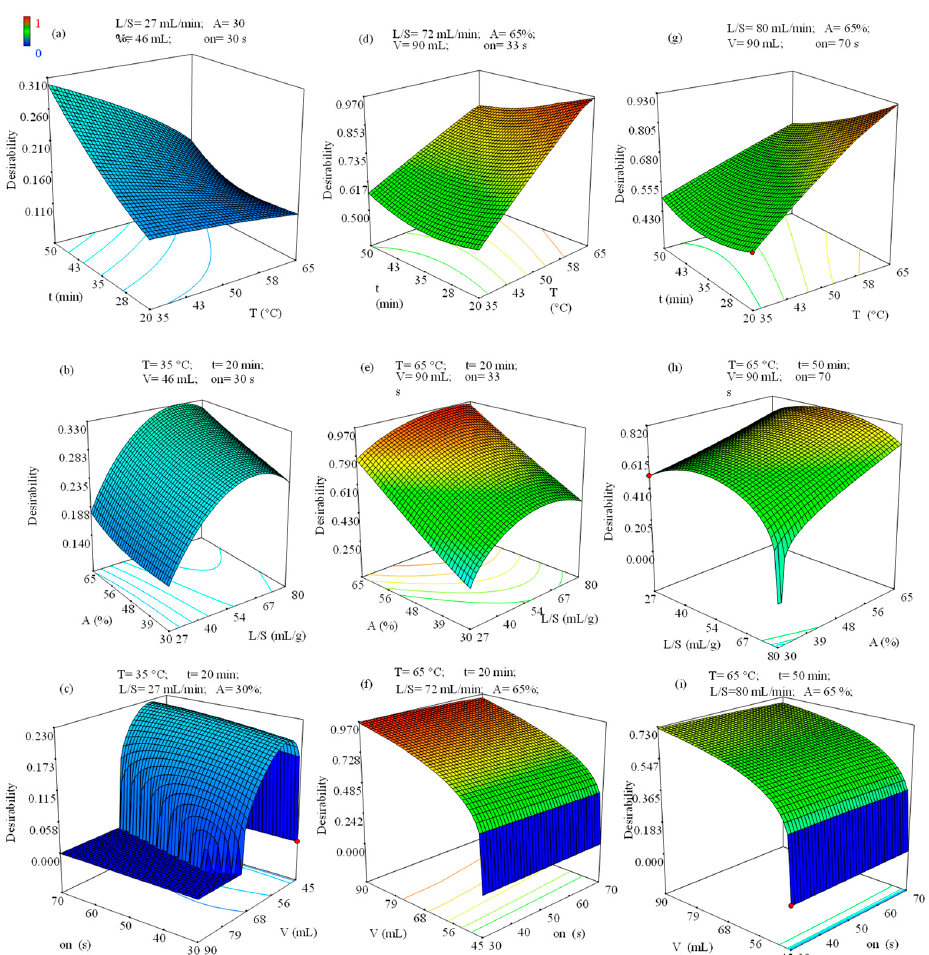
Figure 2. Surface plots of desirability as a function of the input variables: temperature ( T ), time ( t ), ultrasound amplitude ( A ), on/off pulsed ratio ( on ), liquid-to-solid ratio ( L / S ), and volume ( V ).